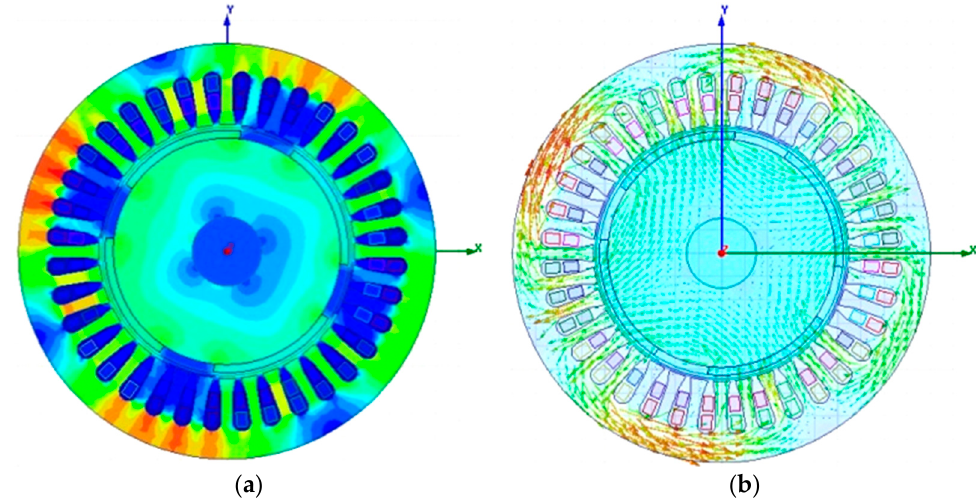
Figure 7. The finite element model of HEBPMG ( a ) Flux density cloud map; ( b ) The distribution of magnetic field lines. Table 1. Structural parameters of the prototype.